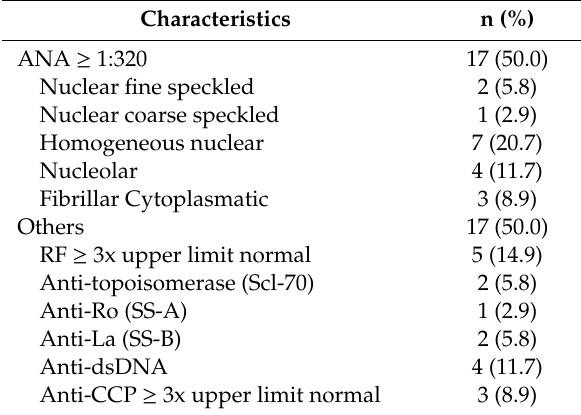
Table 4. Autoimmune serologic